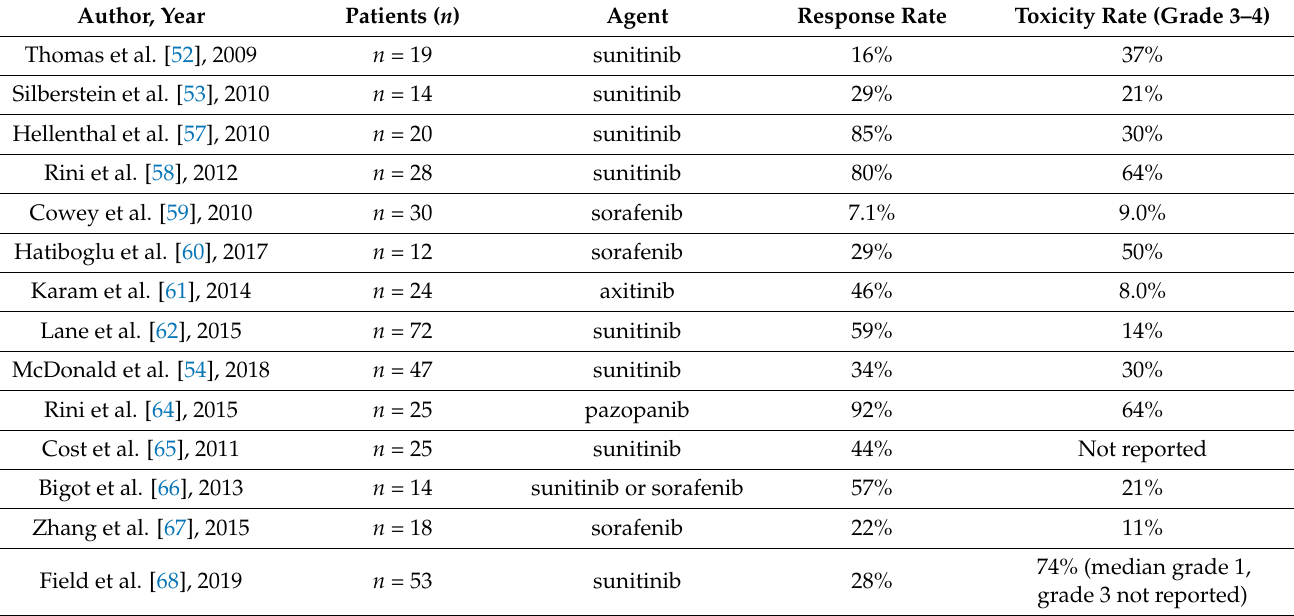
Table 1. Published trials in neoadjuvant therapy in locally advanced renal cell